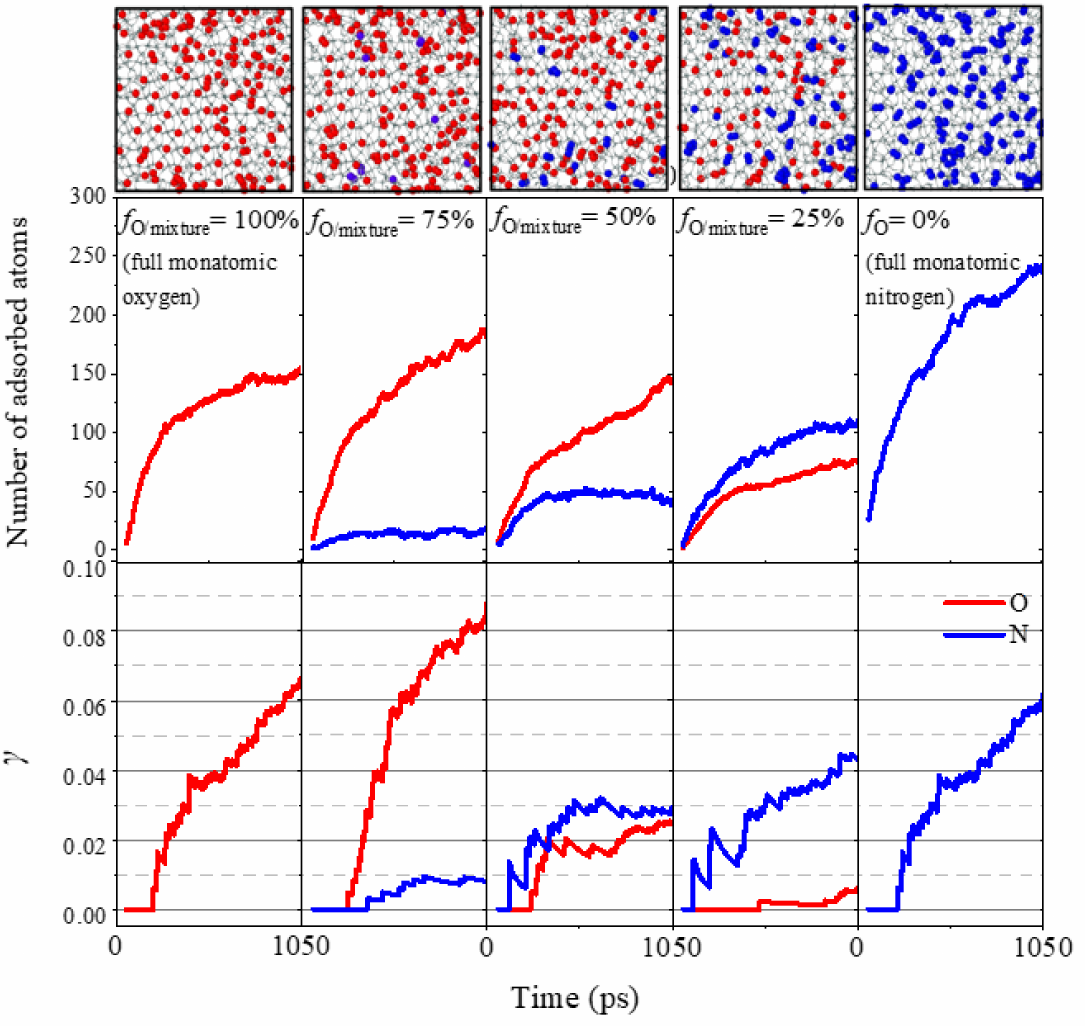
Figure 15. The multicomponent gas effects on the silica surface catalytic